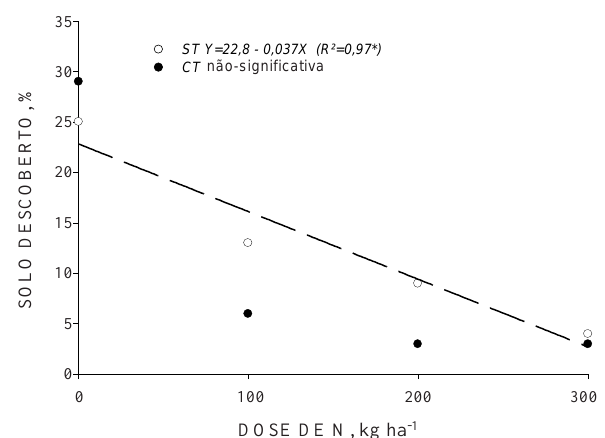
DOSE DE N, kg ha Figura 2. Solo descoberto de acordo com as doses de N aplicadas no inverno (N-TI) em presença (CT) ou ausência (ST) de trevo, 18 dias após a retirada dos animais, Guarapuava (PR) 1999/ 2000.